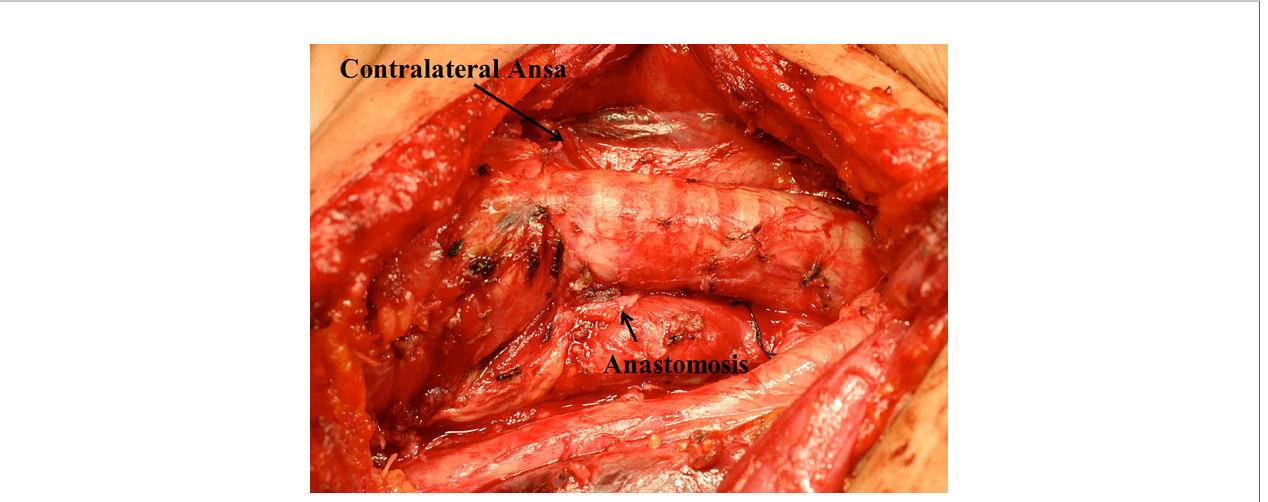
FIGURE 4 | Contralateral ansa cervicalis-to-RLN anastomosis: The contralateral ansa-cervicalis was brought to the side of the defected RLN between the trachea and the esophagus to make contralateral ansa cervicalis-to-RLN anastomosis.